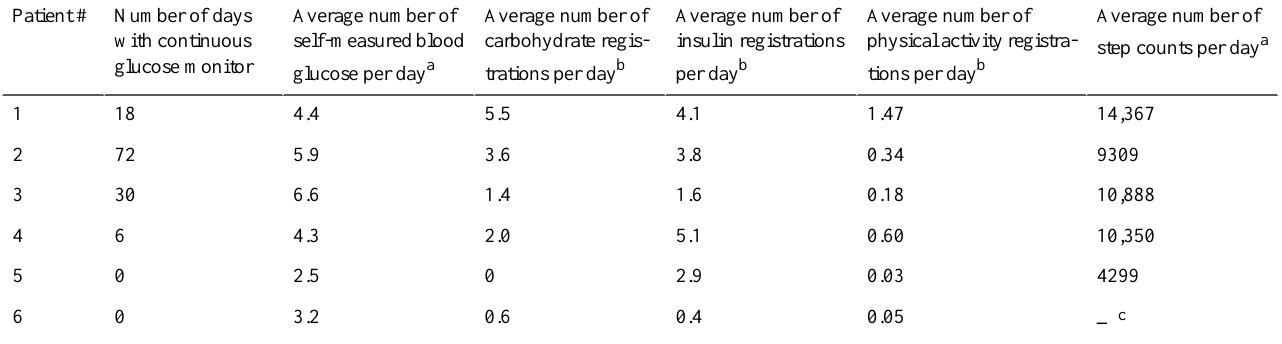
Table 2. Data obtained from 3-month period of using the Diani